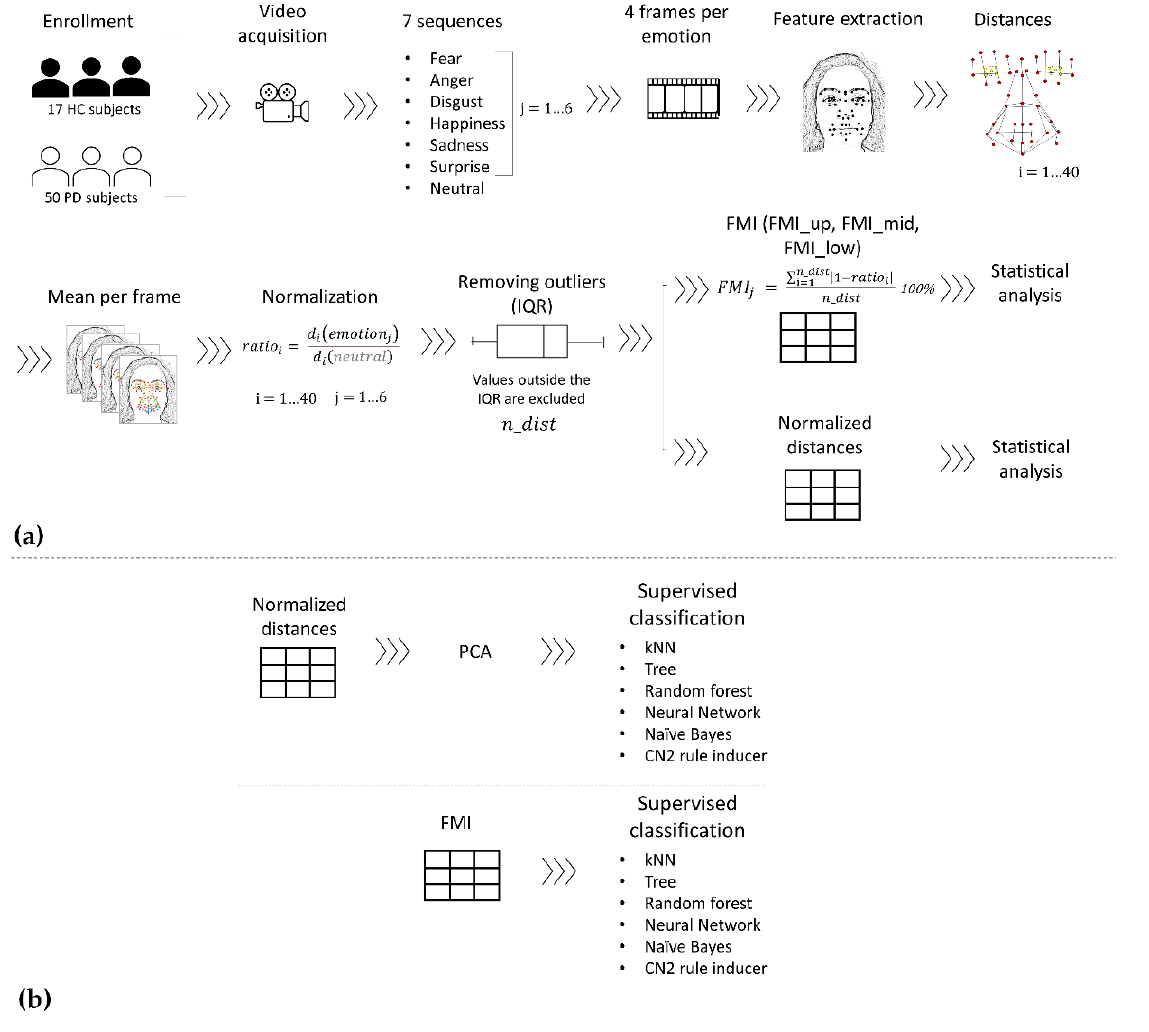
Figure 1. Data processing pipeline: ( a ) FMI definition from raw data to normalized distances and FMI calculation; ( b ) emotion classification with the normalized distances and FMI datasets. The outputs of pipeline ( a ), FMI and normalized distances datasets, are used as inputs for the classification pipeline ( b ).